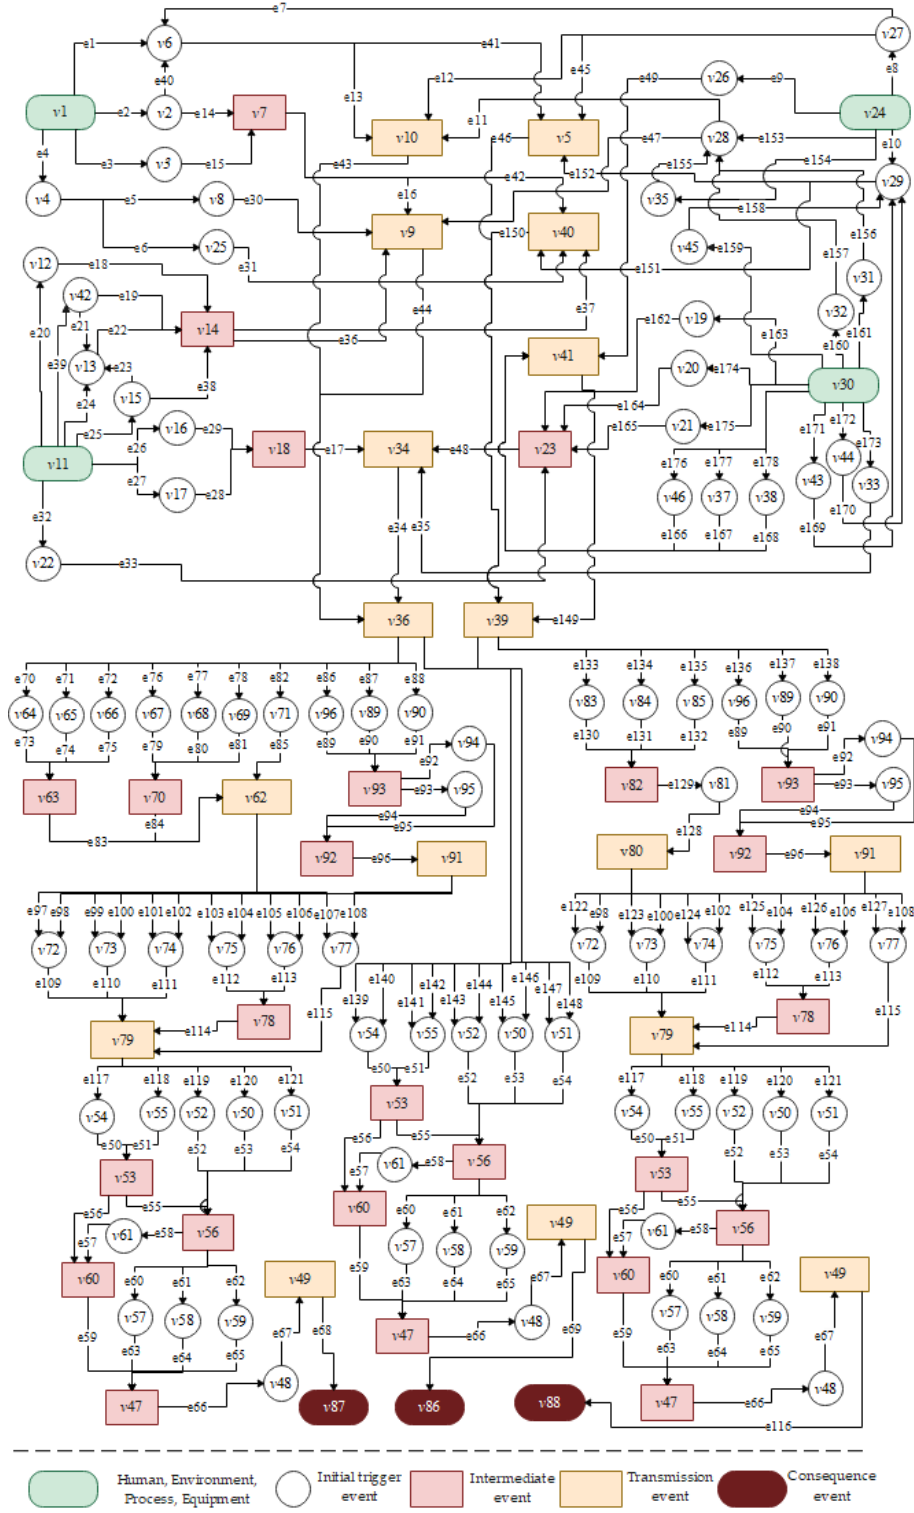
Figure 8. Complex evolutionary network model for fire and explosion accident.